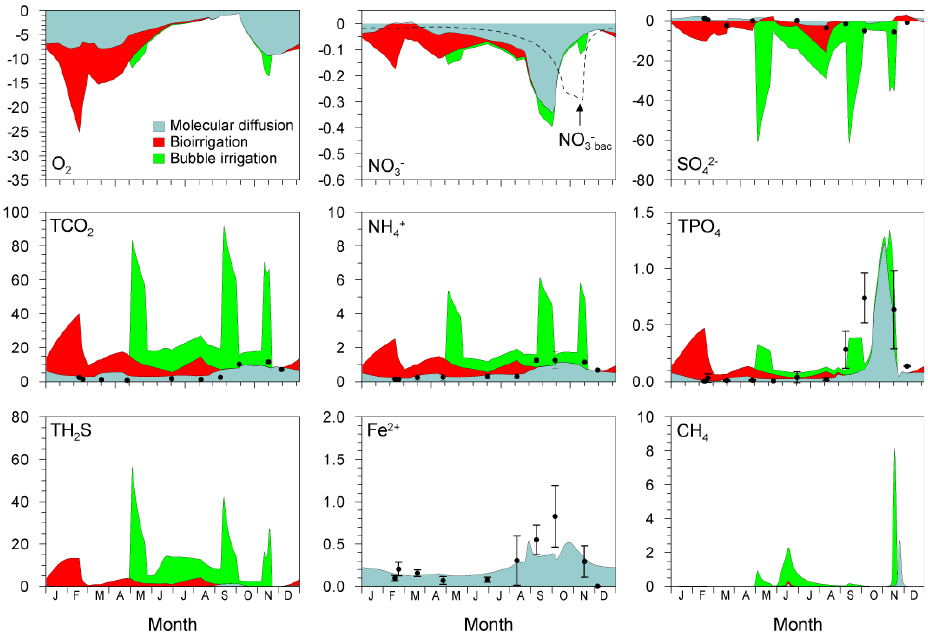
Fig. 5. Modeled solute fluxes across the sediment–water interface (mmolm − 2 d − 1 ) by molecular diffusion, bioirrigation and bubble irriga- tion. The black circles denote the mean ( ± 1 σ ) diffusive fluxes calculated by applying Fick’s law to the measured data. The dashed line in the NO − plot denotes intracellular nitrate transport by Beggiatoa . Negative fluxes are into the sediment. Modeled phosphate fluxes correspond 3 to the simulation considering P uptake and release by Beggiatoa (see